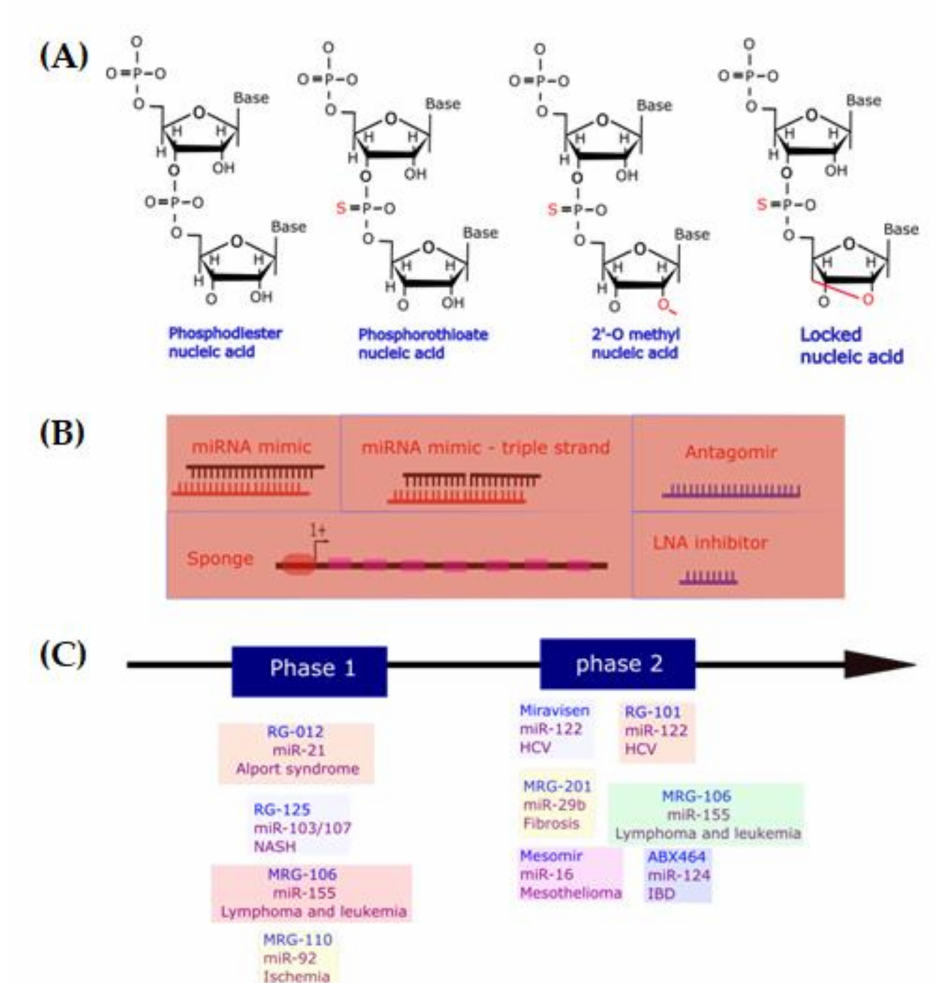
Figure 5. ( A ) Chemical modifications of oligonucleotides; ( B ) miRNA replacement therapy using miRNA mimics, miRNA mimic triple strand; miRNA inhibition therapy using miRNA antagomirs, miRNA inhibitors, and miRNA sponges; ( C ) Current miRNA-based